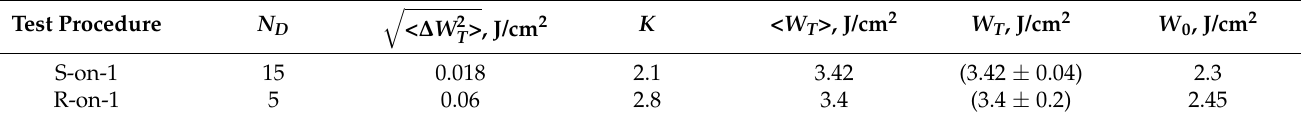
(cid:113) (cid:10) (cid:11) W 2 Table 1. The average error , the K coefficient of the error dispersion at the confidence T probability of P T = 0.95, the average LIDT fluence < W T >, the 0-probability LIDT fluence W 0 for the S-on-1 and R-on-1 tests with damaged site number N D .